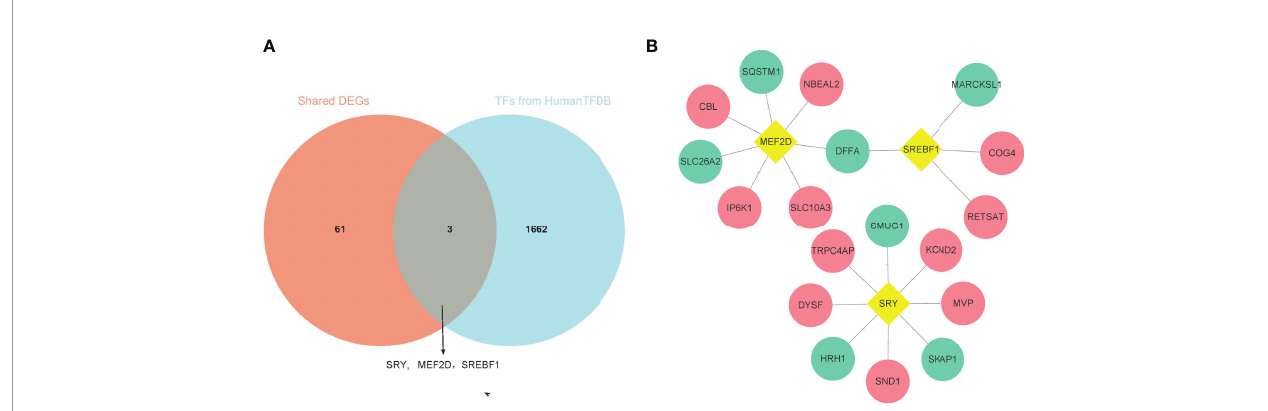
FIGURE 3 | Identi fi cation of shared TFs. (A) The venn diagram of 64 SDEGs and 1665 TFs obtained from HumanTFDB, SRY, MEF2D, and SREBF1 were identi fi ed as shared TFs. (B) Network of TFs-SDEGs, the yellow rhombus represented TFs, the pink circle represented up-regulated SDEGs, and the blue circle represented the